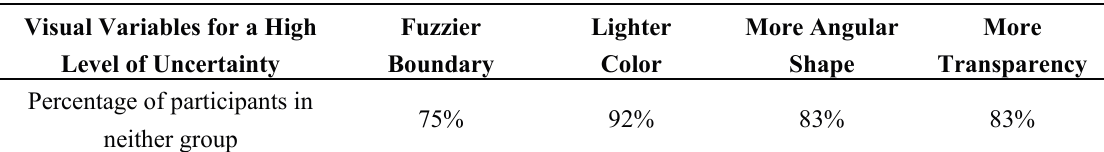
Table A1. Percentage of participants in neither group who prefer for different visual variables to represent a high level of uncertainty.